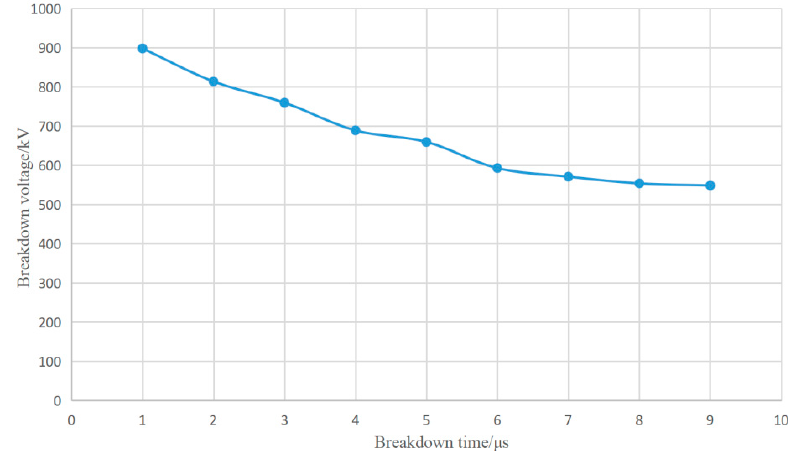
Figure 10. Voltage–time curve of the device. Table 3. Data of the volt-second characteristics test ( T = 29.9 °C, P = 95.6 kPa, RH = 46%).